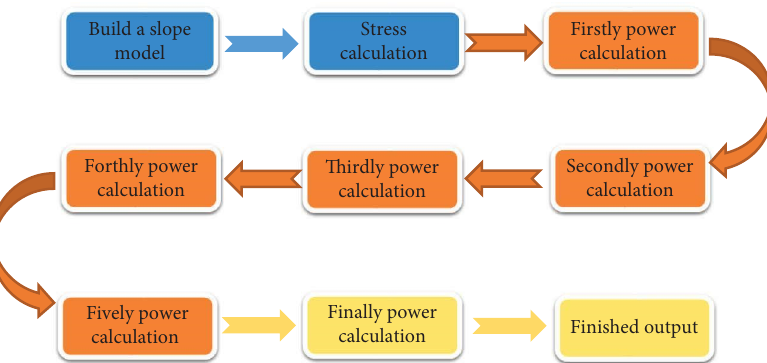
Figure 7: Schematic diagram of calculation